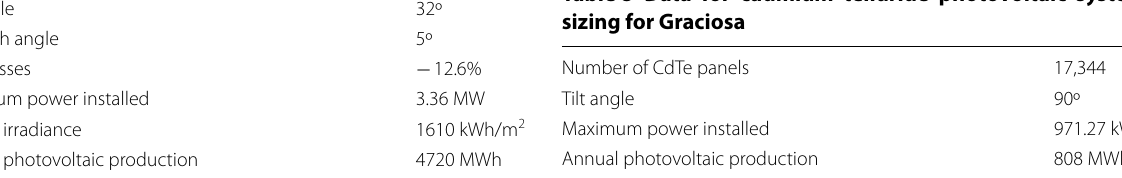
Table 8 Data for cadmium telluride photovoltaic